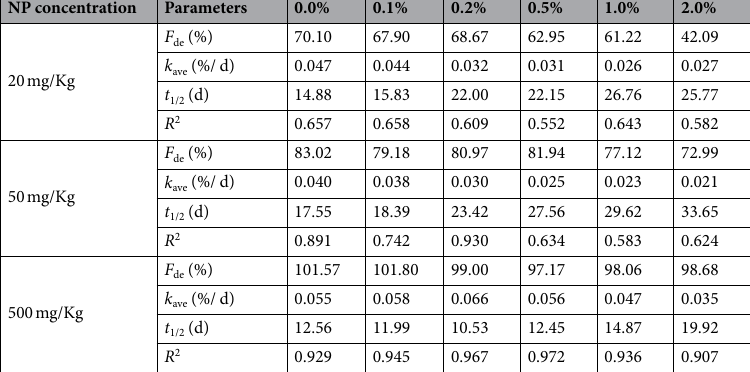
Table 1. Fitted parameters of biodegradation curves of NP in RC-sediment system.